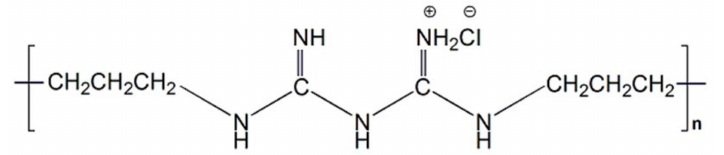
Figure 1. Chemical structure of poly(hexamethylene biguanide) hydrochloride